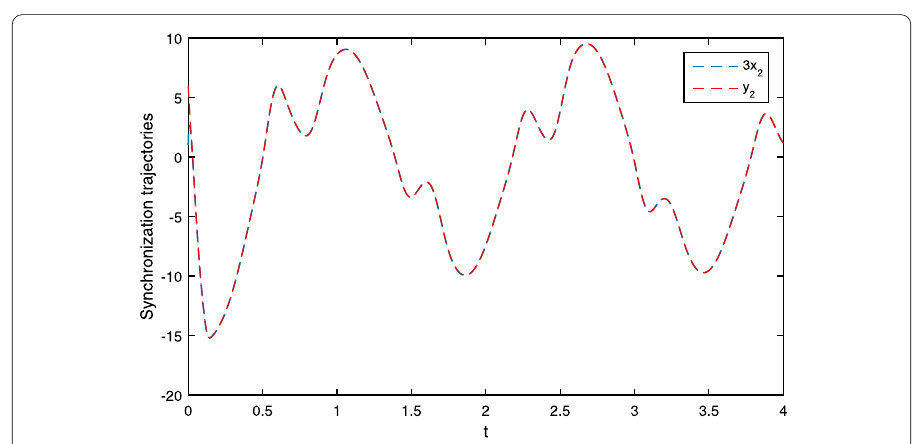
Figure 10 The synchronization trajectories of x 2 , y 2 with β =